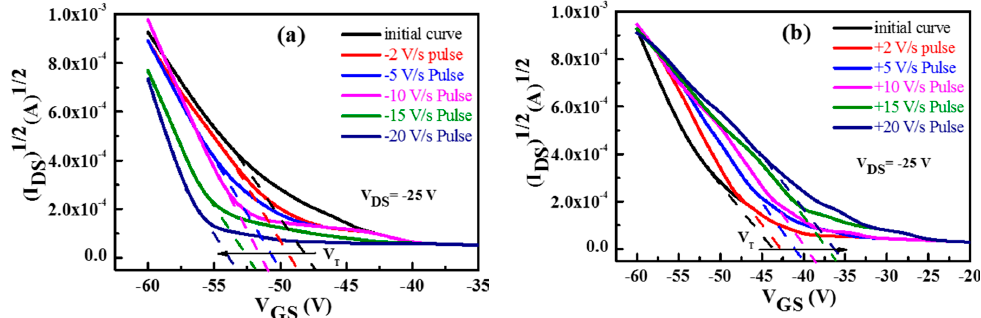
Figure 5. The effect of ( a ) negative and ( b ) positive pulses on transfer characteristics for SWCNT-based OTFMT.